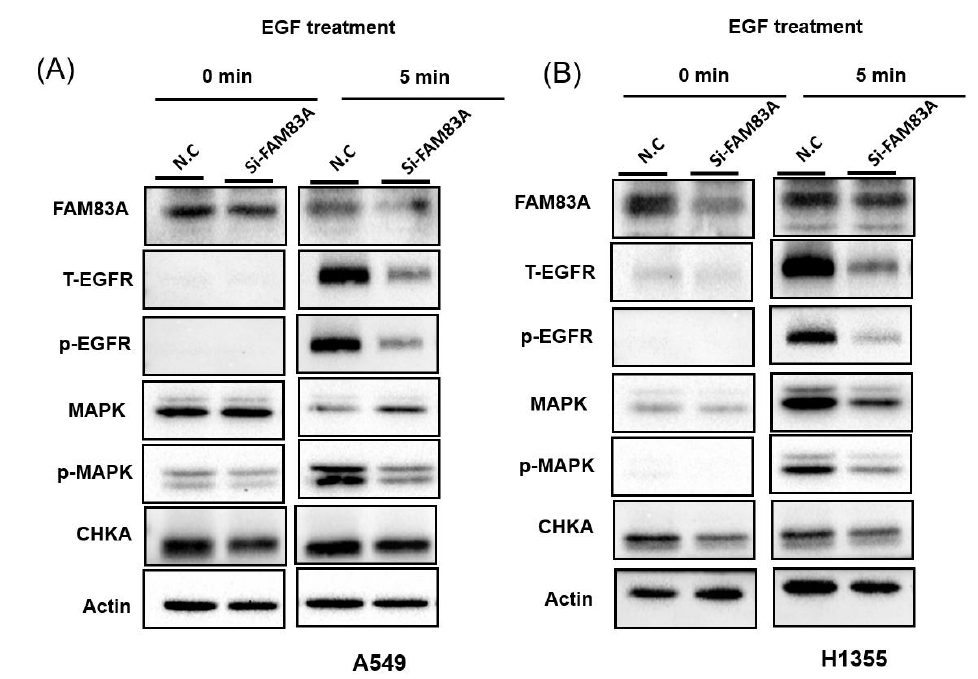
Figure 5. FAM83A knockdown–induced inhibition of lung cancer cell growth and motility by choline metabolism signaling. After 5 min of Epidermal growth factor (EGF) treatment, the expression levels of Epidermal growth factor receptor (EGFR), Phosphorylation-EGFR (p-EGFR), Mitogen-activated protein kinae (MAPK), Phosphorylation-MAPK (p-MAPK), and Choline kinase alpha (CHKA) in ( A ) A549 and ( B ) H1355 cells with FAM83A knockdown were assessed using Western blot assay. N.C. indicates a random siRNA sequence control. All experiments were performed in triplicate, and the data were analyzed using Student’s t test. Differences were considered significant when p < 0.05.